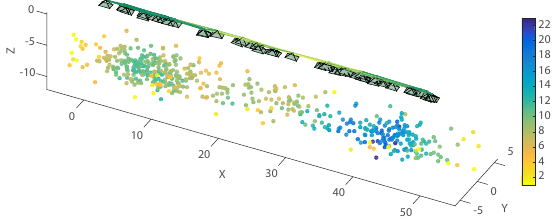
Figure 5: Synthetic arrangement of images used for the evalua- tion of weighting relative rotations.